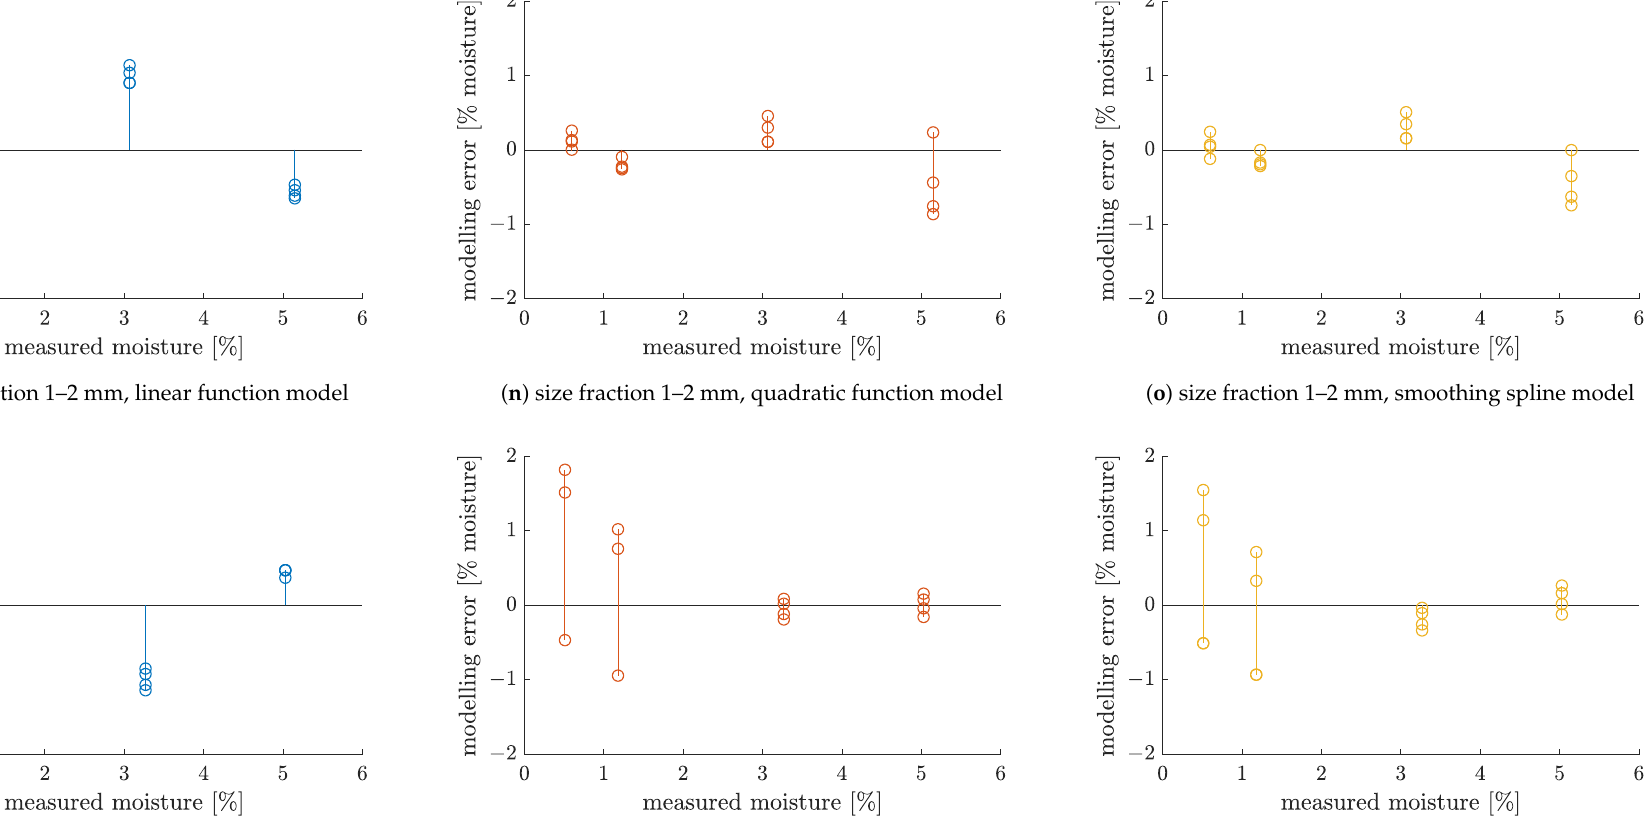
Figure A2. Errors of inverse models (material moisture vs. image median intensity) as obtained in leave-one-out